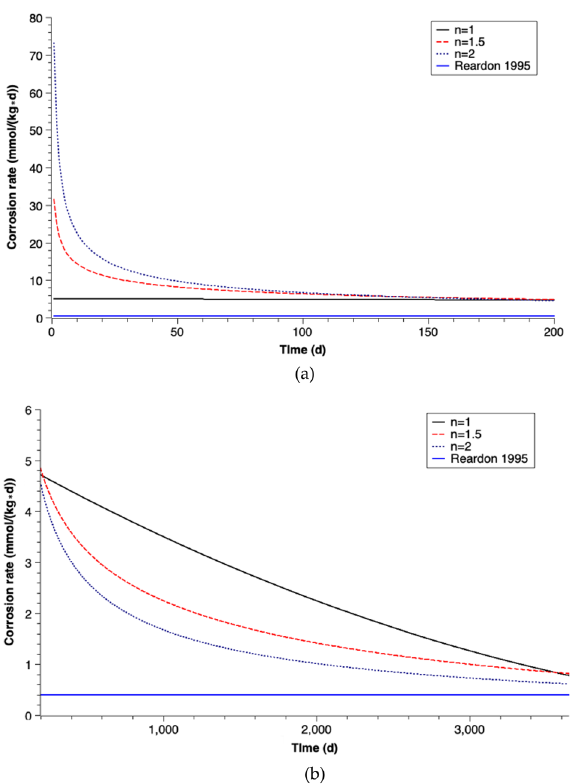
Figure 8. Comparison of corrosion rates with results from Reardon 44 (n is the coefficient of